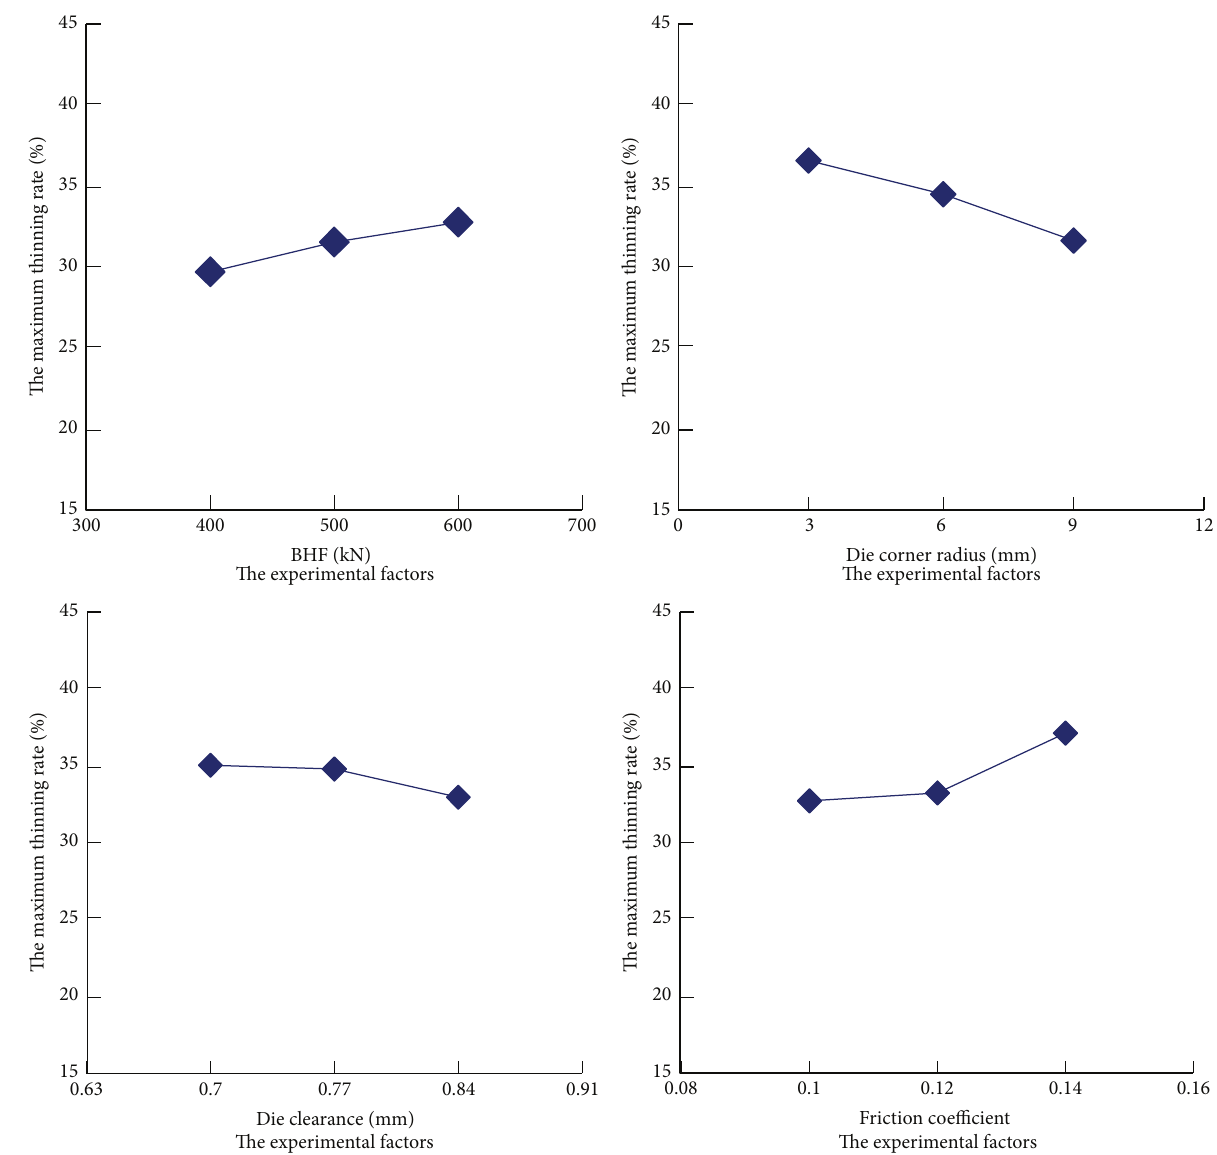
Figure 4: Relationship between the maximum thinning rate and experimental